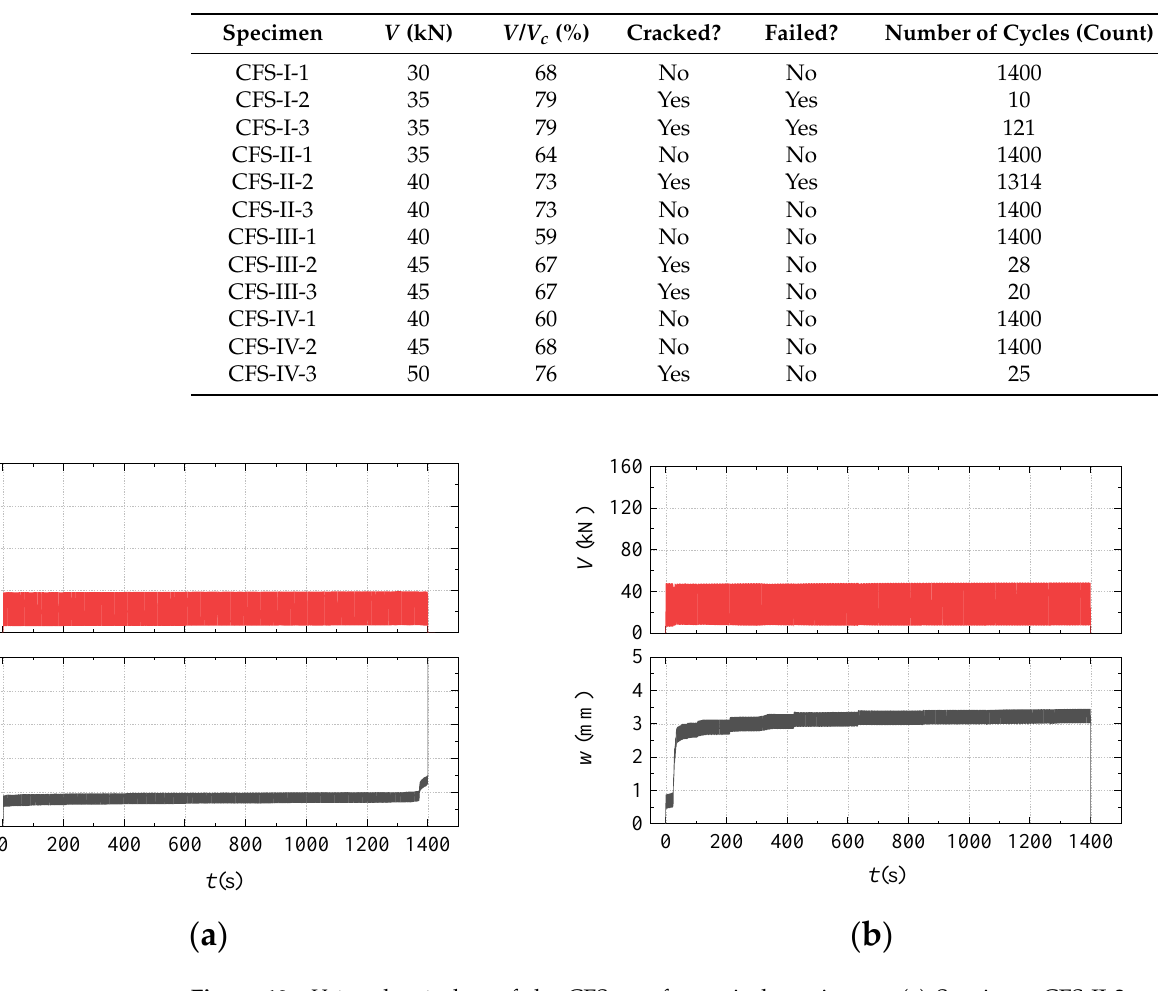
Figure 10. V-t and w-t plots of the CFS test for typical specimens: ( a ) Specimen CFS-II-2 and ( b ) Specimen Table 3. Results of CFS test.